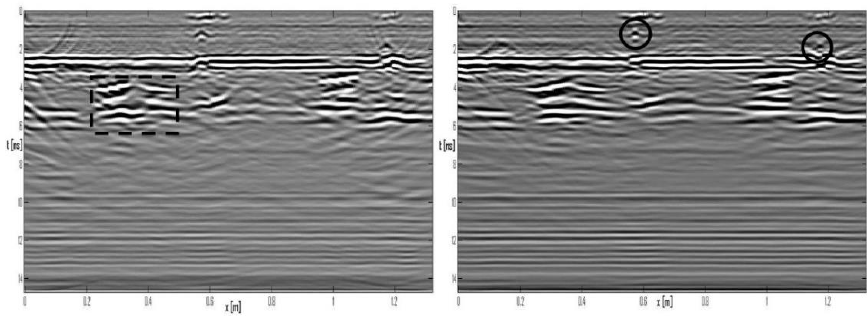
Figure 5. Migrated data. Left-hand panel: v = v 1 = 12 cm / ns. Right-hand panel: v = v 2 = 13 cm / ns.